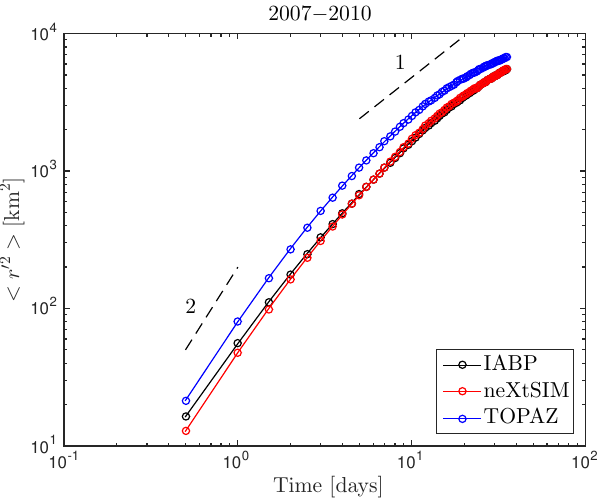
Figure 10. Ensemble mean of the variance of the fluctuating dis- placement < r (cid:48) 2 > for the winter seasons 2007–2011 for IABP, TOPAZ and neXtSIM. The dashed lines indicate the theoreti- cal slopes for the two diffusion regimes: the ballistic regime ( (cid:104) r (cid:48) 2 (t) (cid:105) ∼ t 2 ), which has a slope equal to 2, and the Brownian regime ( (cid:104) r (cid:48) 2 (t) (cid:105) ∼ t ), which has a slope equal to